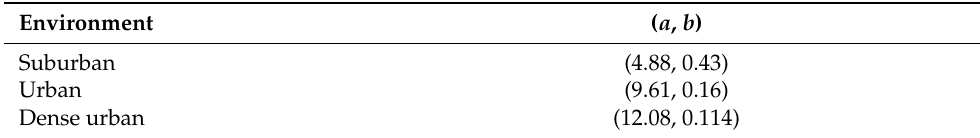
Table 3. The values of ( a , b ) for different urban environments.